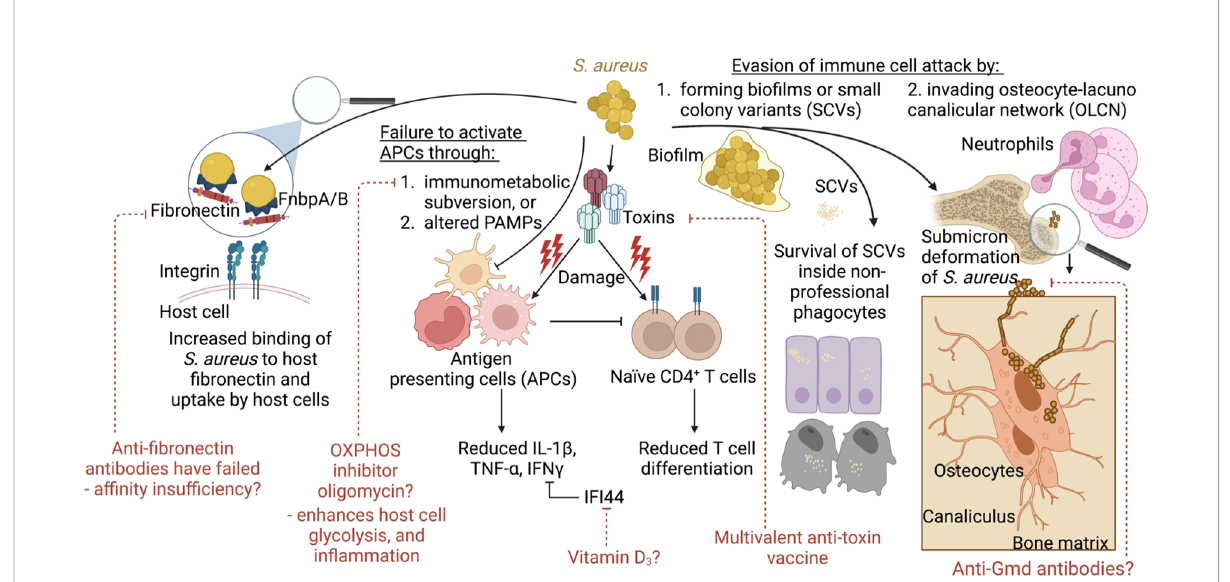
FIGURE 3 Model summarizing the concepts covered and their links to vaccine development and alternative therapies. During infection, S. aureus employs several strategies to evade immune clearance. This includes increased binding to host fi bronectin and uptake by host epithelial or endothelial cells. S. aureus also impairs immune responses through toxin-mediated immune cell damage. This may be counteracted through the use of multivalent anti-toxin vaccine. S. aureus fails to activate immune cells for pathogen clearance via immunometabolic subversion, such as skewing the host cell metabolism away from glycolysis and in fl ammatory signaling towards OXPHOS. Alternatively, S. aureus escapes immune cells and antibiotics through the formation of bio fi lms, or small colony variants (SCVs) that survive inside non-professional phagocytes. In addition,